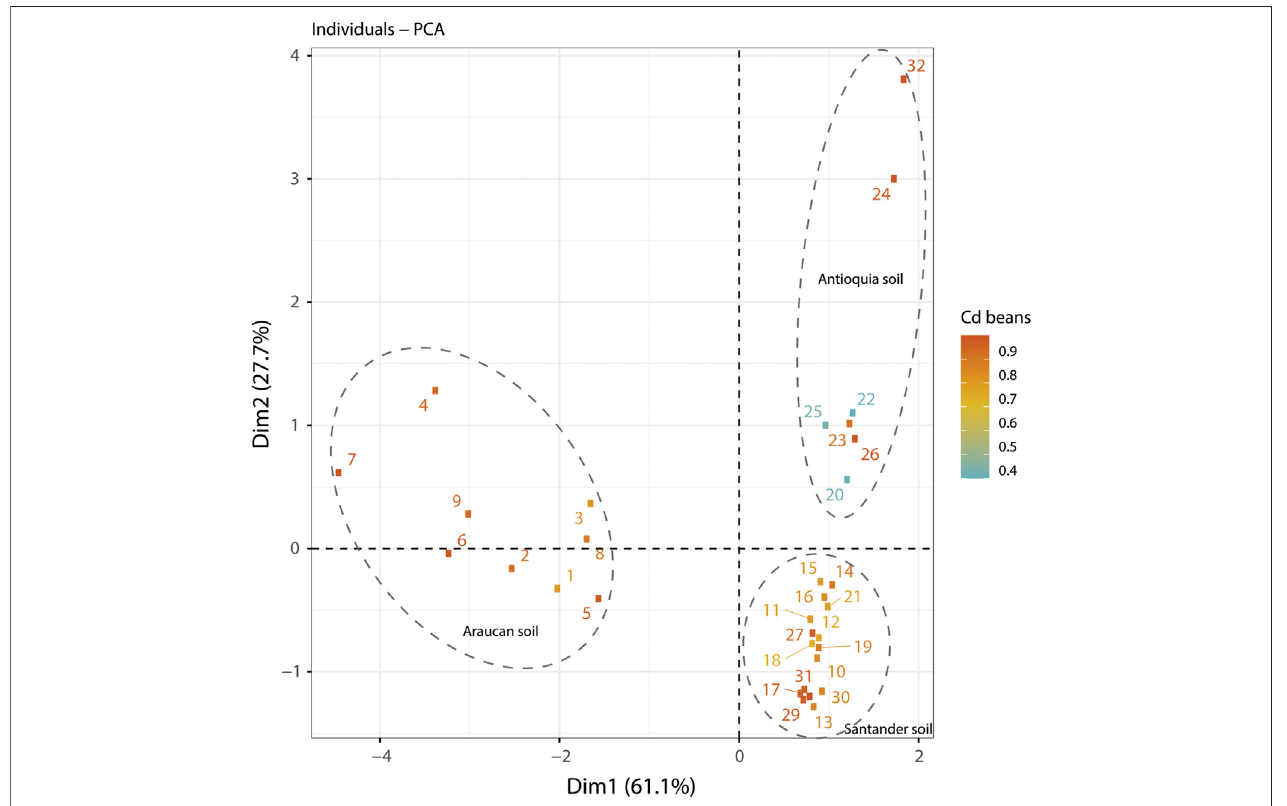
FIGURE7| APCA analysisofsoilsamplesfromAntioquia, AraucaandSantander. Thescree plotsuggestedthat61.1%oftheexplainedvarianceswereobserved in dimension 1. The origin of soil samples was clustered into each assessed location. The scale shown the Cd content in cacao beans as reference variable.